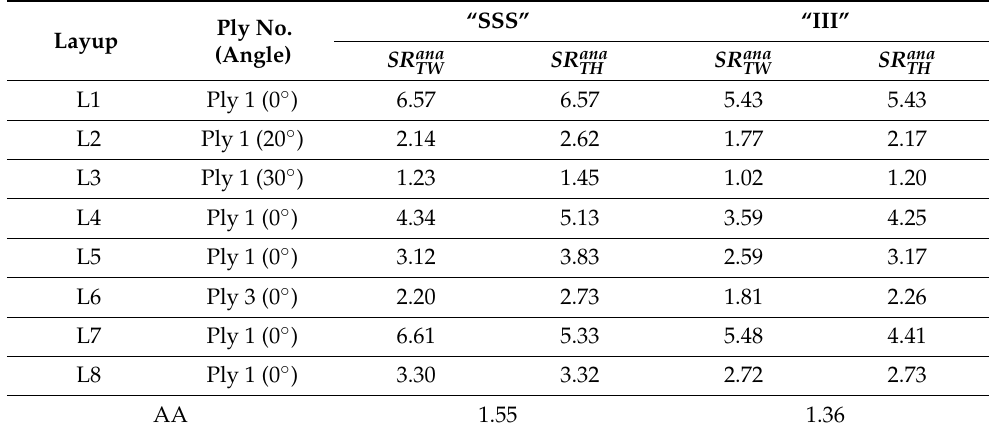
Table 5. Comparison of plies with minimum safety ratios (SRs) in “SSS” and “III” beams (flange under compression); see Figure 3c for a laminate stacking sequence